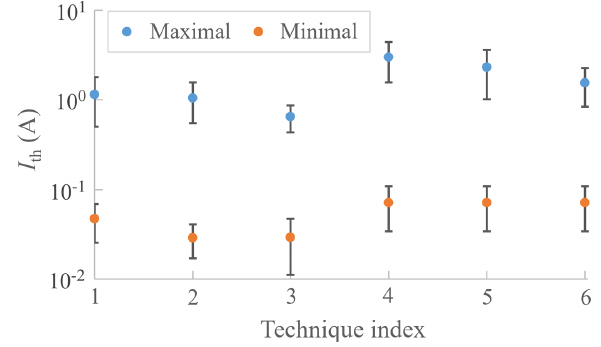
FIG. 14. Minimal and maximal threshold current values achiev- able with different BBU mitigation techniques for 10 randomized configurations of MESA.